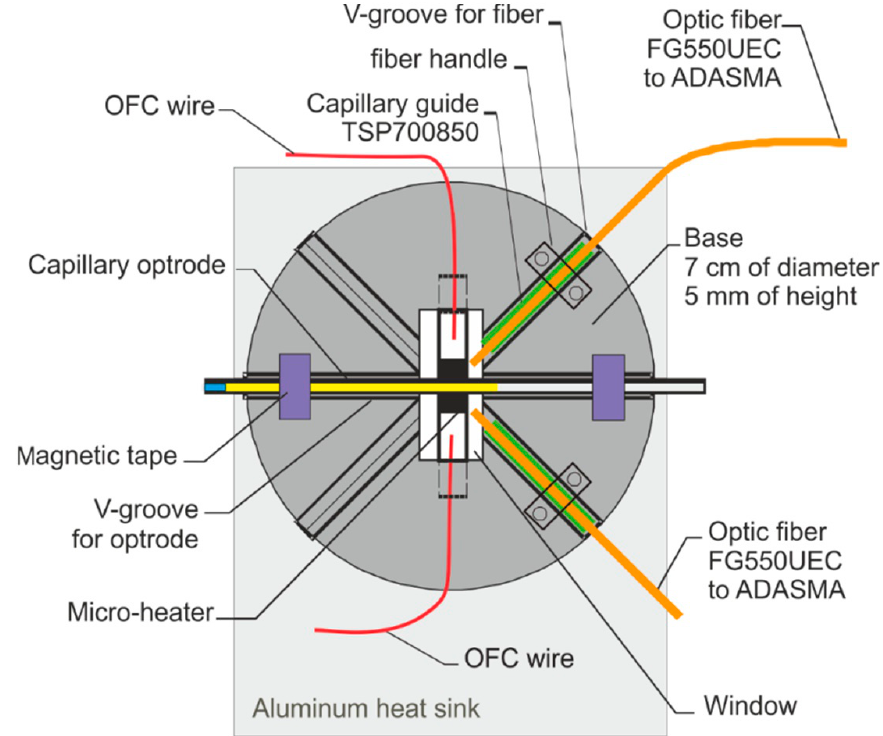
Figure 7. The schematic of the head.